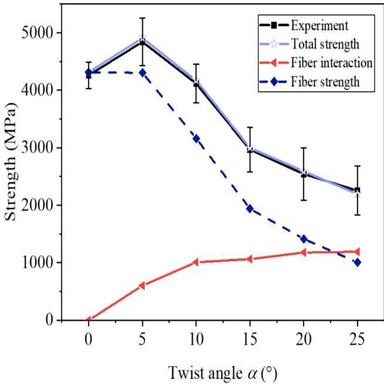
Changes in the total strength of carbon fiber tows, frictional resistance, and fiber strength with increasing twist angle.